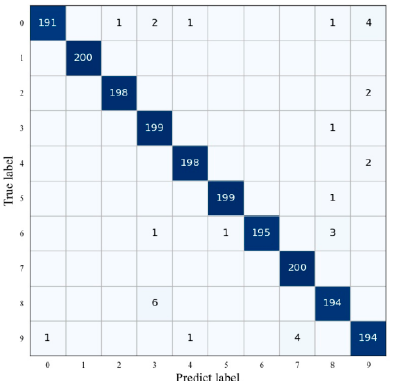
Figure 13. Confusion matrix of the 28 × 28 size of the input trajectories.